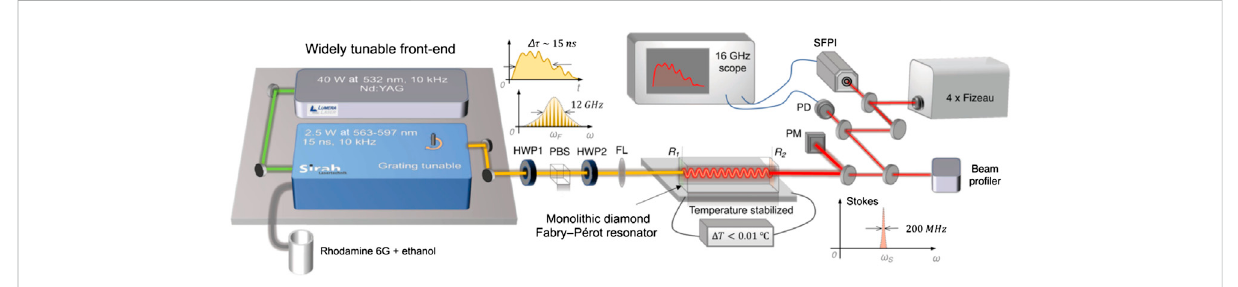
FIGURE 8 ExperimentsetupoftheSLMmonolithicdiamondlaserat0.614 μ m[22].HWP,half-wave-plate;PBS,polarizingbeamsplitter;FL,focusinglens; PM, power meter; PD, photodiode; SFPI, scanning Fabry-Perot interferometer. Image originally published in Ref. [22] and reproduced with permission according to the open access licenses © [2022] Optica Publishing Group under the terms of the Optica Open Access Publishing Agreement.